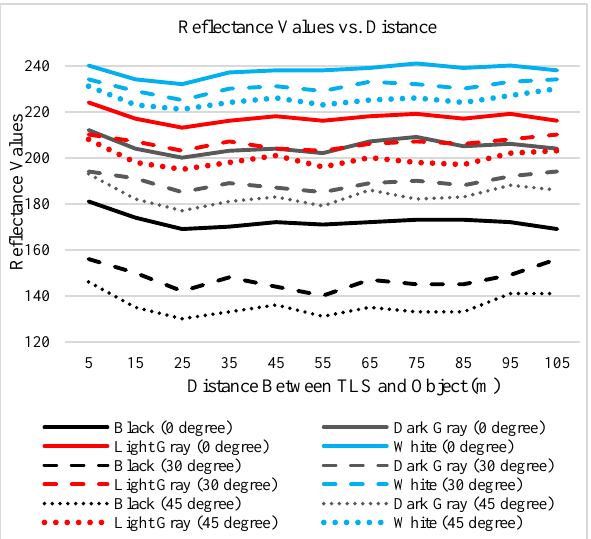
Figure 6. Mean reflectance values